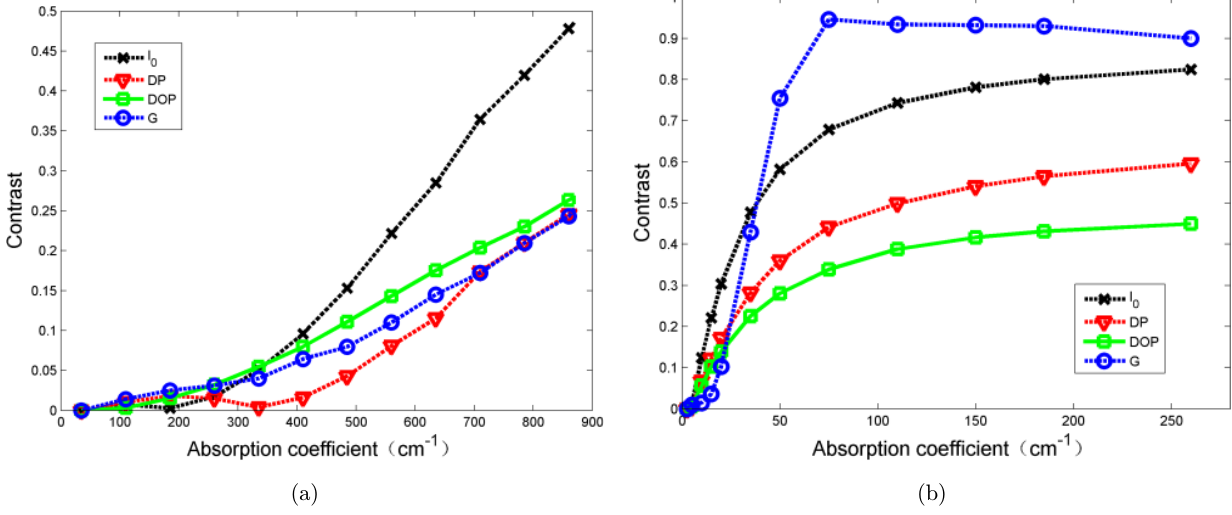
Fig. 5. Simulated relative contrasts of four imaging parameters: intensity, DP, DOP, RLPI parameter G at di®erent absorption coe±cients for a two-layer structure with top isotropic layer and bottom anisotropic layer. (a) The absorption coe±cient varies from 35 to 900 cm (cid:1) 1 in top layer, (b) The absorption coe±cient varies from 2.7 to 250 cm (cid:1) 1 in bottom